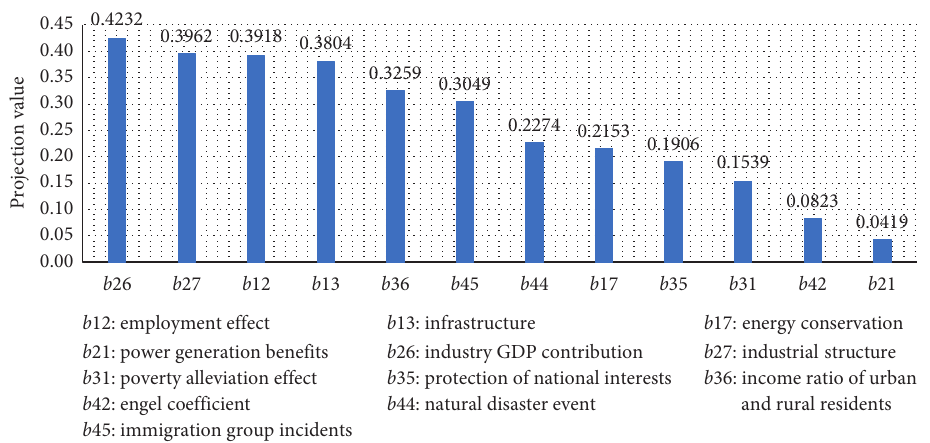
Figure 2: Projection direction of evaluation indicators. Table 2: Projected social impact of hydropower projects.